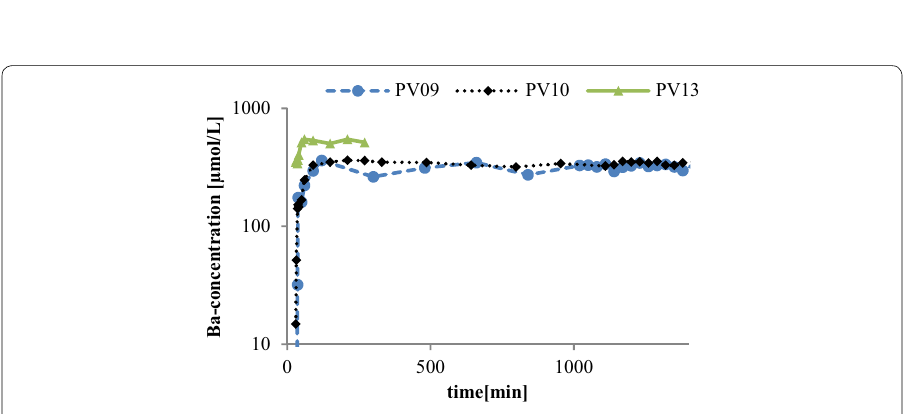
Fig. 6 PV09 (20 °C/300 bar), PV10 (20 °C/20 bar), and PV13 (150 °C/300